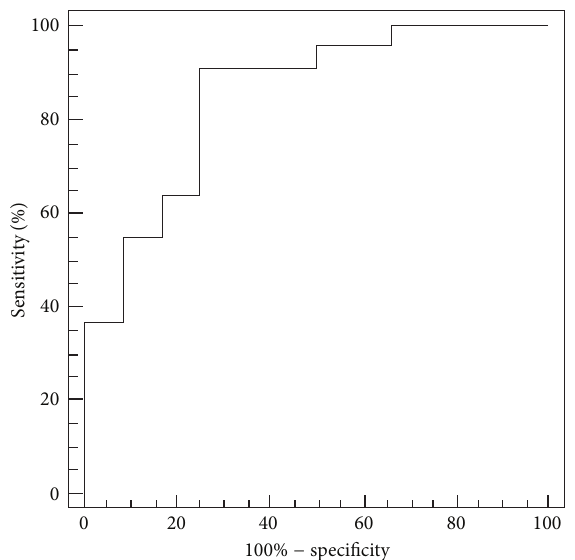
Figure 3: ROC analysis. The best decrease in PES cutoff with which to differentiate between responders and nonresponders is 18.8%, which yields a sensitivity of 91% and a specificity of